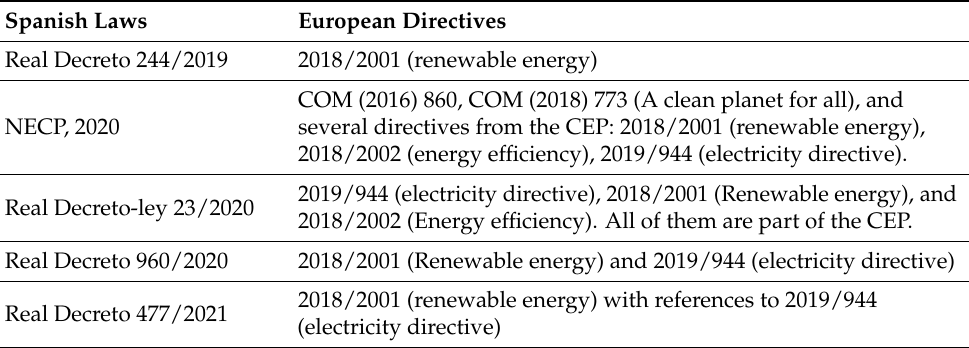
Table 1. Summary of the relationship between Spanish laws and EU